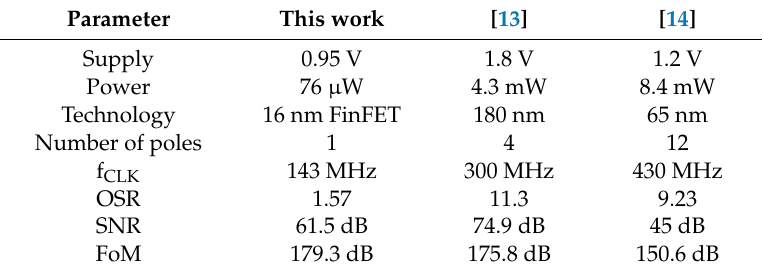
Table 3. Performance summary and state-of-the-art